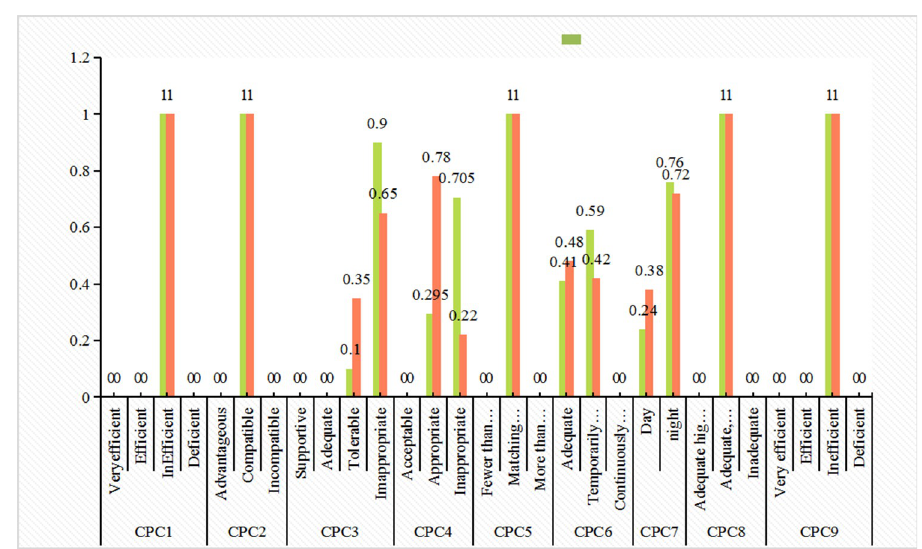
Fig 6. Position NO.11 BN diagnostic data